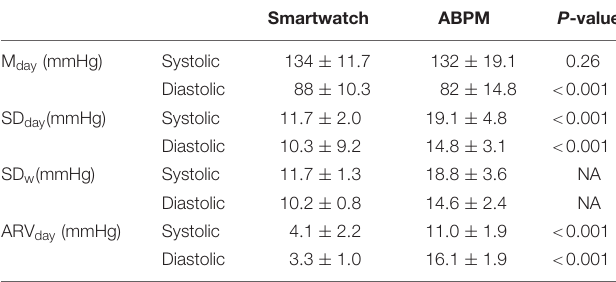
TABLE 3 | Blood pressure mean and blood pressure variability: mean ± SD over N = 40 participants, with significance p of the difference between devices. Smartwatch